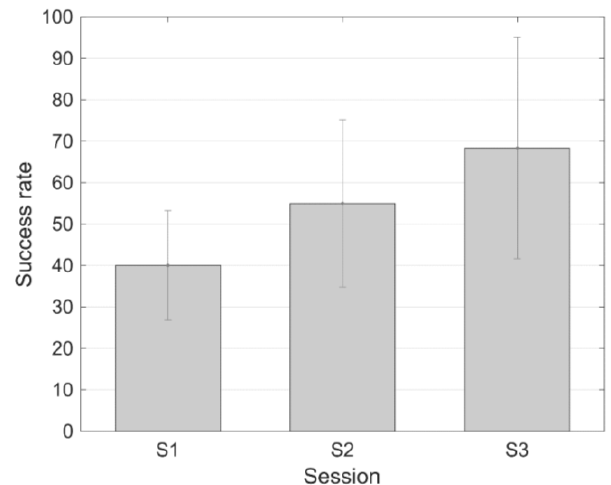
Figure 8. Success rate (mean ± standard error of the mean) during the different sessions of the protocol with shorter training periods.